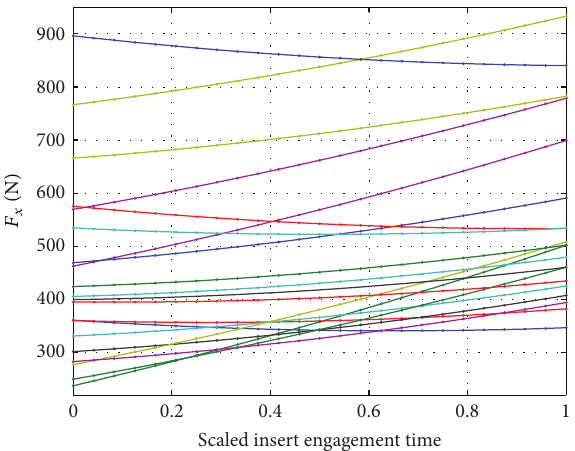
Figure 3: Functional data made out of recorded data for cutting force component in 𝑋 direction during end milling experiments.